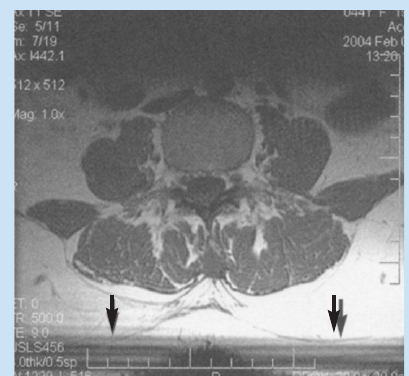
Fig. 11. Slice-to-slice interference (T1 axial study of lumbar